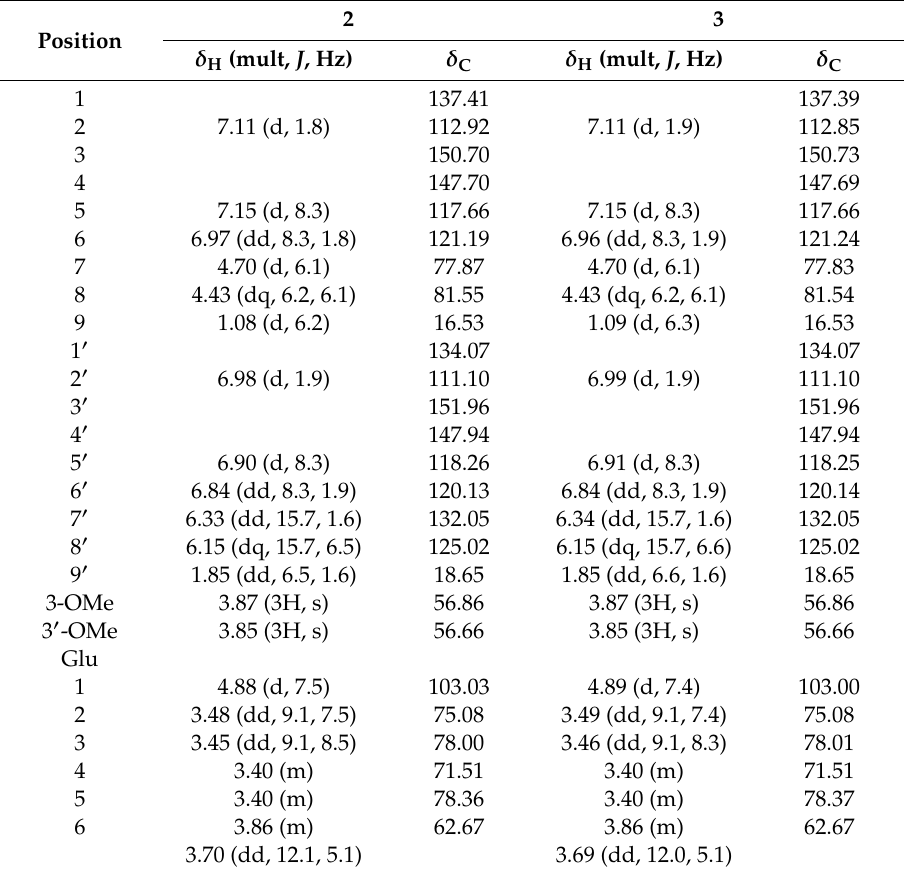
Table 2. 1 H- and 13 C- NMR spectroscopic data of compounds 2 – 3 a (in CD 3 OD).